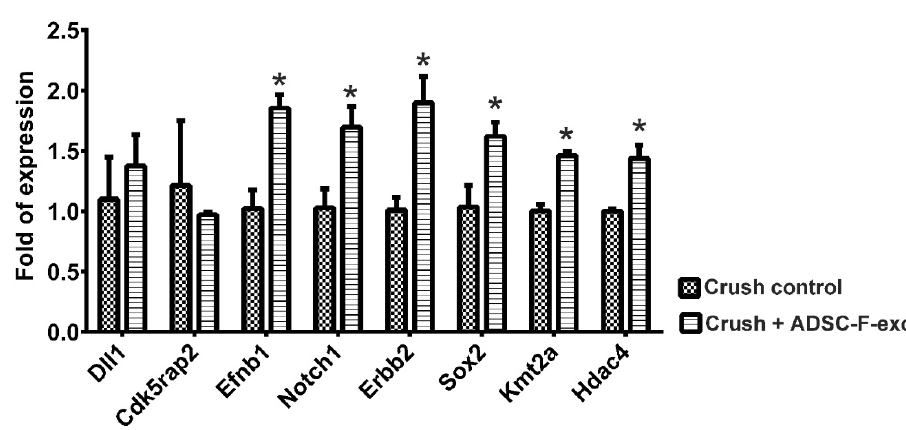
Figure 4. RT-qPCR was performed to validate upregulated genes detected in nerve specimens on post-crush day 2 following ADSC-F-exo treatment vs. those in nerve crush control nerve. Upregulated genes were identified according to the mouse neurogenesis PCR array. RT-PCR, quantitative reverse transcription-PCR analysis. Statistical analysis was performed by one-way analysis of variance with a post-hoc Fisher’s least significant difference test. * indicated a statistical significance which was set at p <